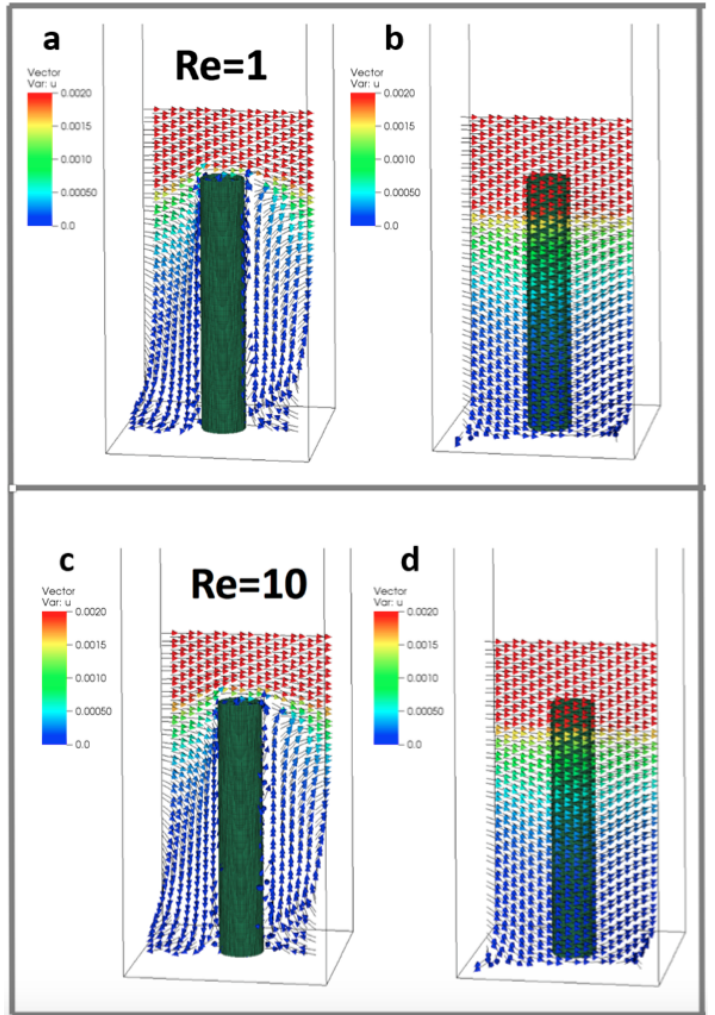
Figure 6. Velocity vectors along planes taken parallel to the direction of flow and through the center of the cylinder ( a,c ) and between periodic cylinders ( b,d ) at Re = 1,10 ( Re d = 0.03125,0.3125). Reynolds numbers were changed by varying the dynamic viscosity. The height of the cylinder is set to 0.156, such that H / D = 5 and G / D =